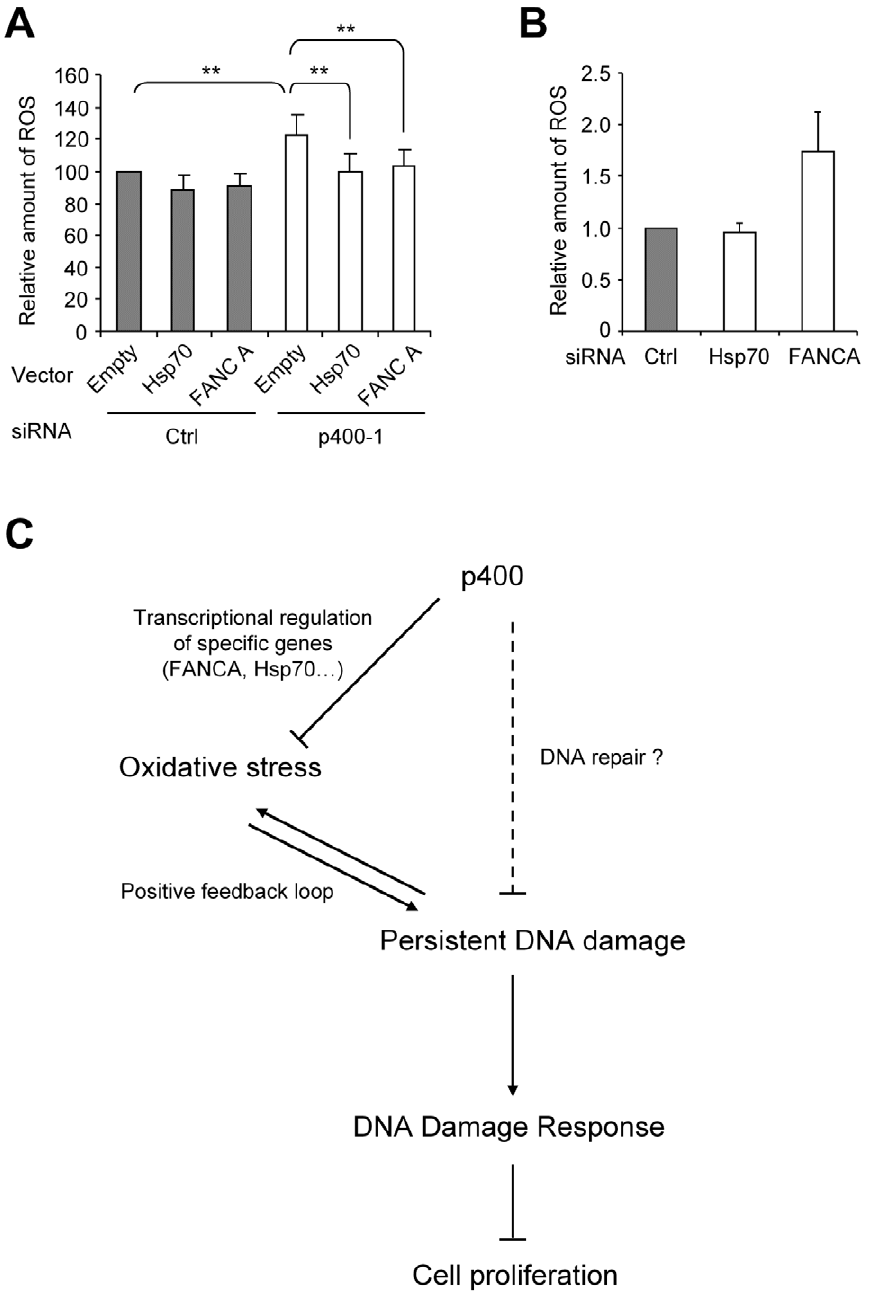
Figure 8. Transcriptional regulation of Hsp70 is involved in ROS controls by p400. (A) U2OS cells were transfected using the indicated siRNA and Hsp70 or FANCA expression vector (1.5 m g). Total amount of DNA in the transfection was kept constant using the corresponding empty vector. 48 h later, cells were collected and ROS levels were measured by flow cytometry and calculated relative to 1 for cells transfected by the control siRNA and empty vector. The mean and SD from three independent experiments are shown. The two stars (**) indicate a p value below 10 5 (Student t-test). B) U2OS cells were transfected using the indicated siRNA and 48 h following transfection, cells were collected and ROS levels were measured by flow cytometry. The mean and SD from 3 independent experiments are shown (after standardisation relative to 1 for cells transfected with the control siRNA). (C) Our model of cell proliferation control by p400: p400 prevents oxidative stress through transcriptional regulation of specific promoters. Oxidative stress in turn induces persistent DNA damage. These persistent DNA damages favour an additional oxidative stress increase (‘‘positive feedback loop’’) and induce the activation of the DNA damage response pathways, resulting in a potent inhibition of cell proliferation (through senescence, cell cycle arrest or apoptosis induction depending on the cell type). The dash line represents a putative role of p400 in DNA repair (demonstrated in other species), which may contribute to the persistence of DNA damage.